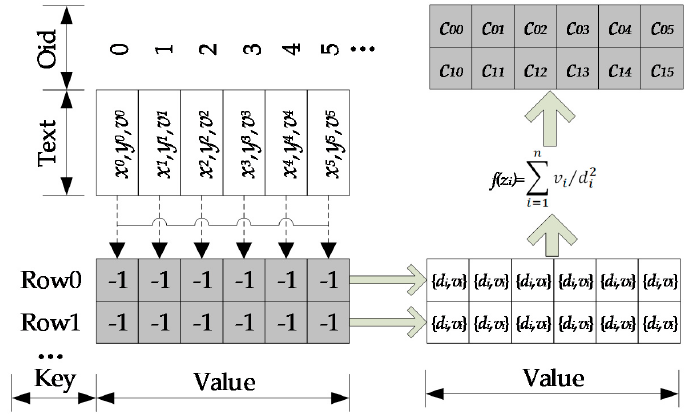
Figure 5. Parallel algorithm example for spatial interpolation.